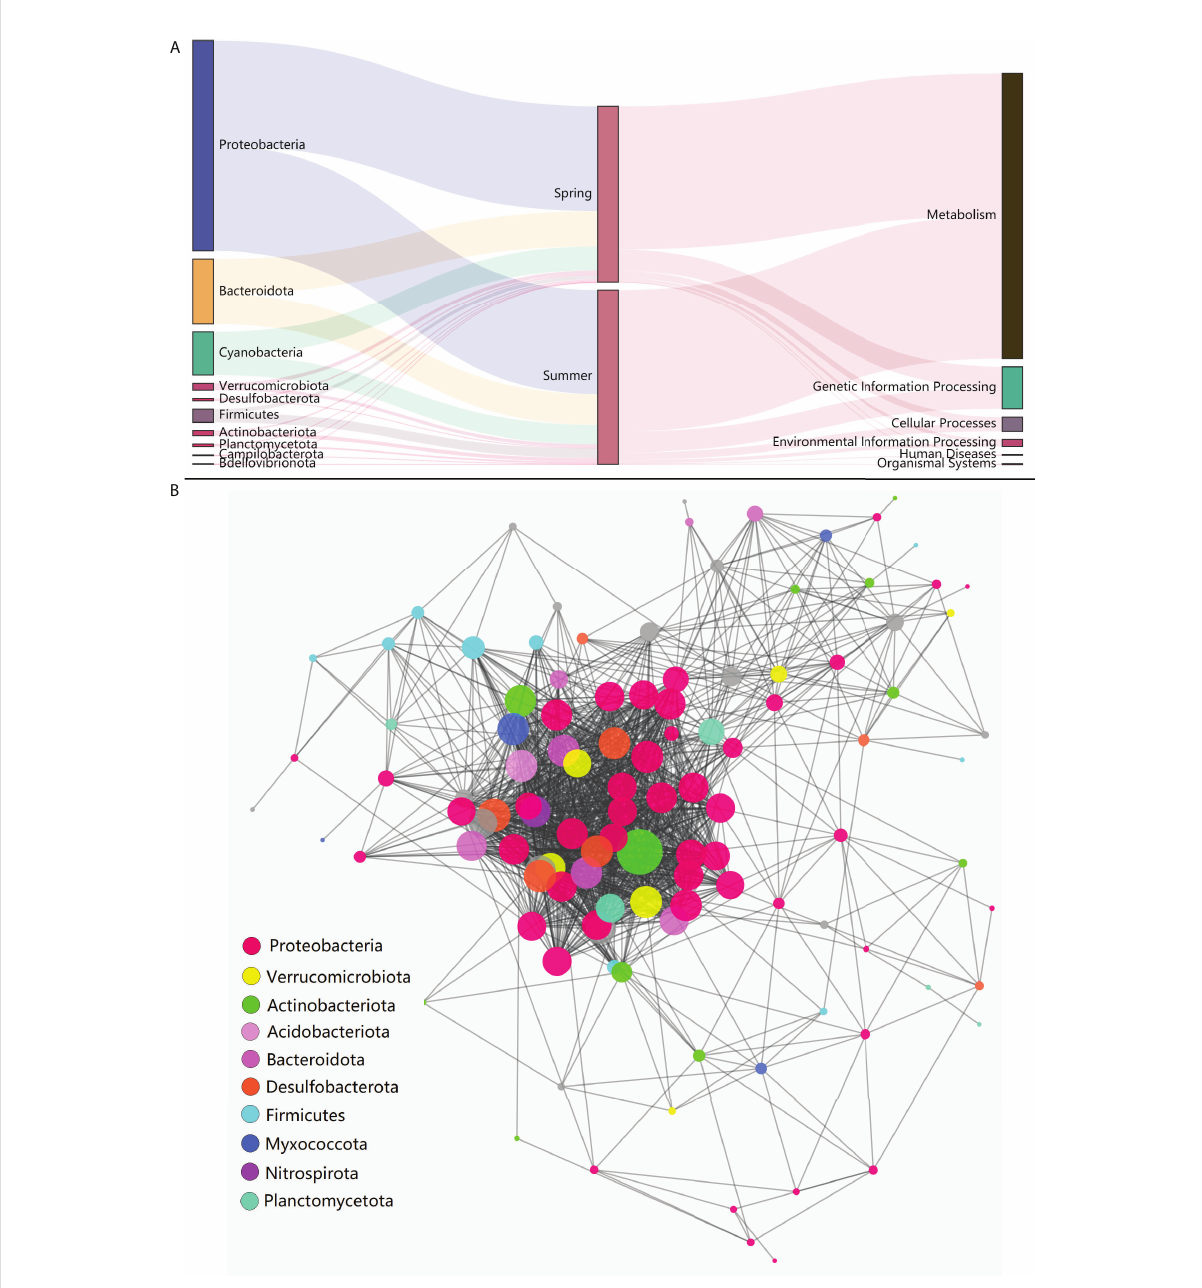
FIGURE 1 Composition, function and co-occurrence of bacterial community. (A) Distribution pro fi les of phylum taxa and functional pathways of the bacterial community; (B) Microbial co-occurrence networks at phylum-order